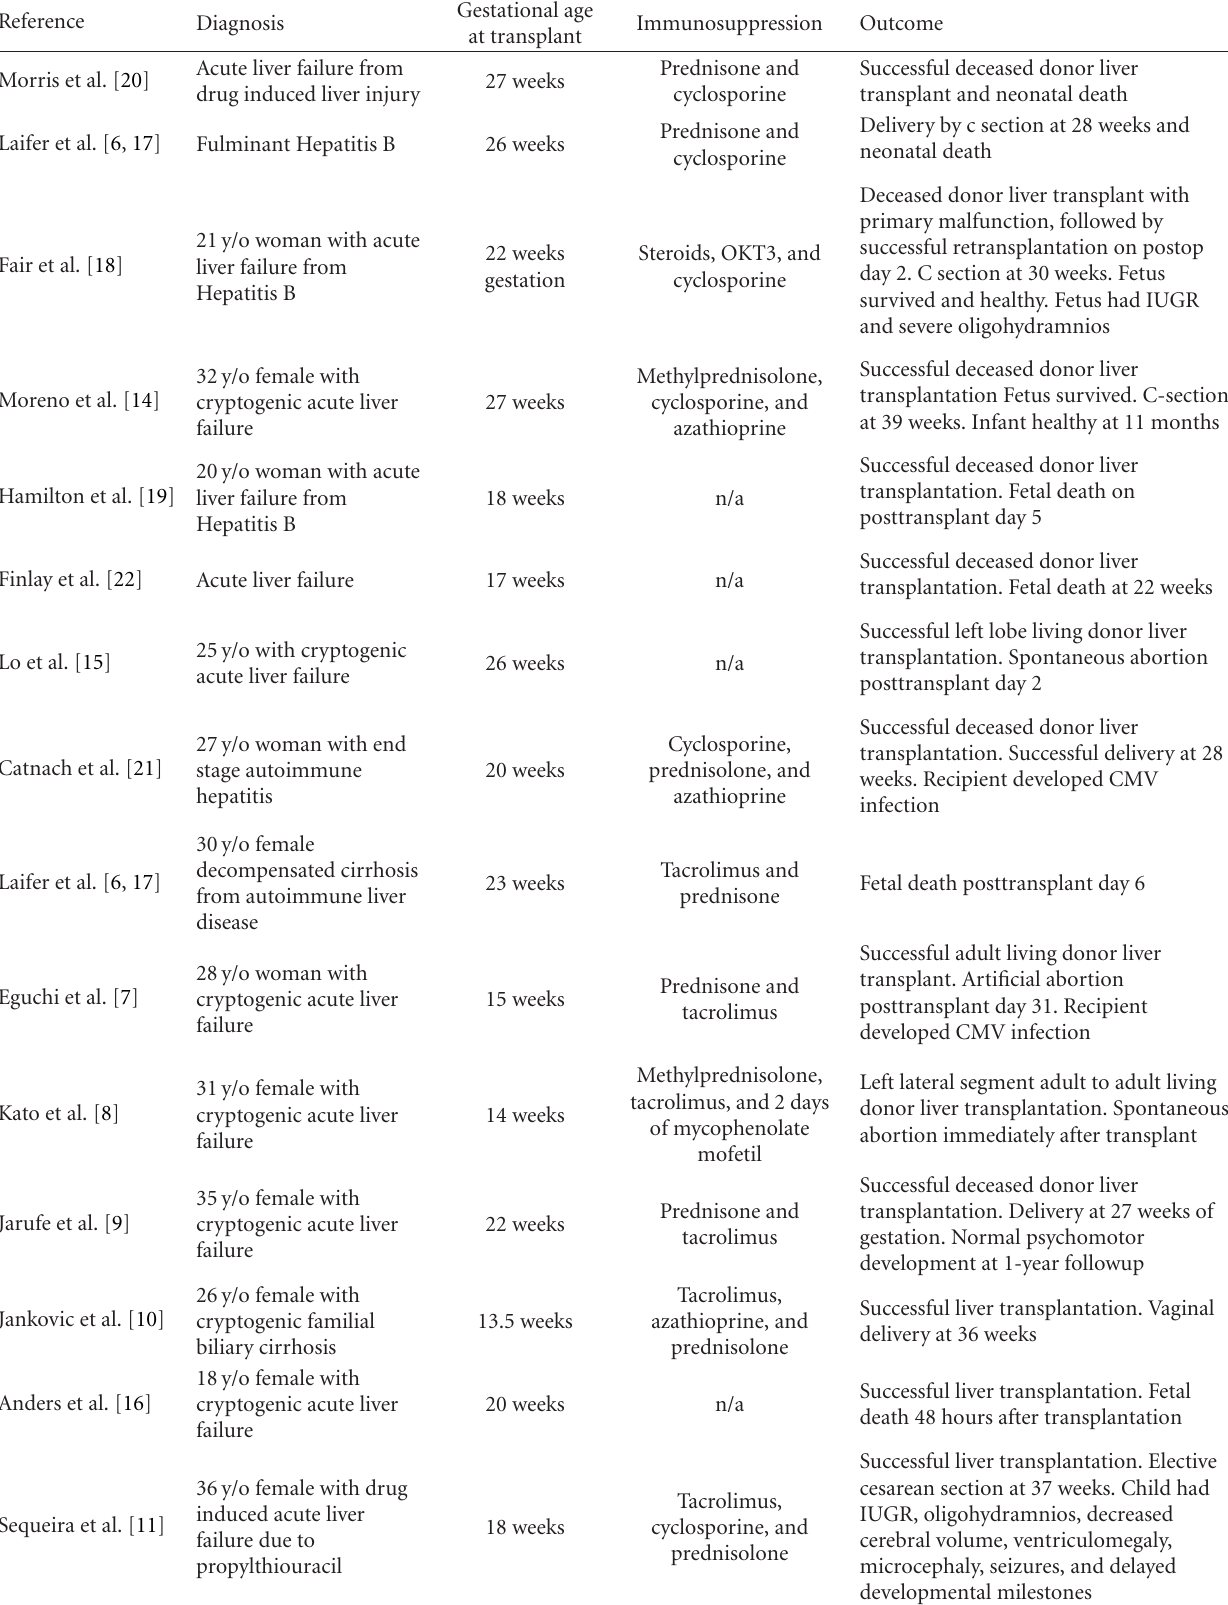
Table 2: Review of cases of liver transplantation during